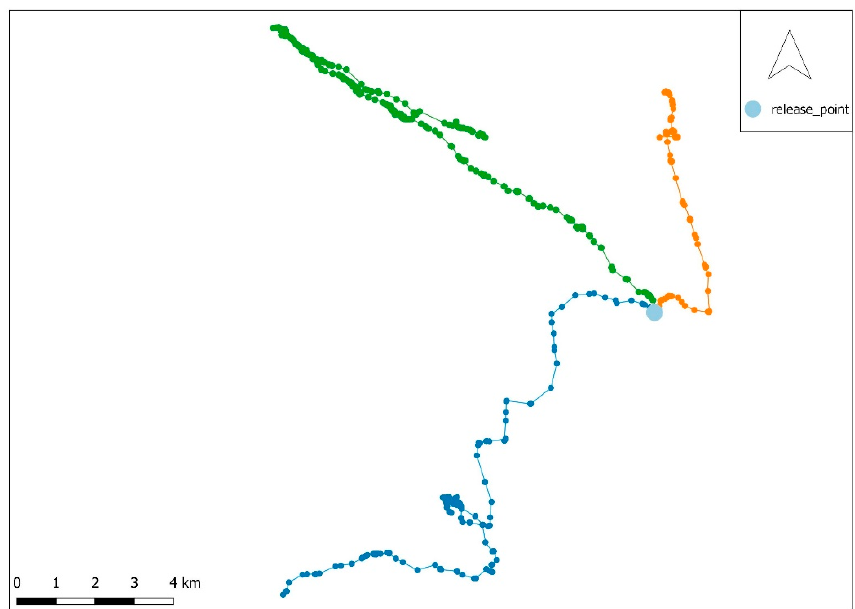
Figure A2. Maximum distances western grey kangaroos moved from the release site following relocation.